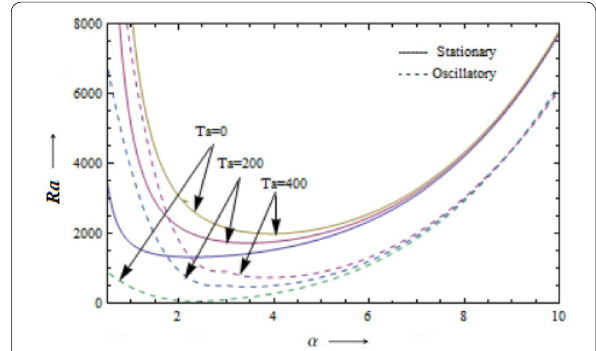
Fig. 5 Effect of rotation parameter on Rayleigh number